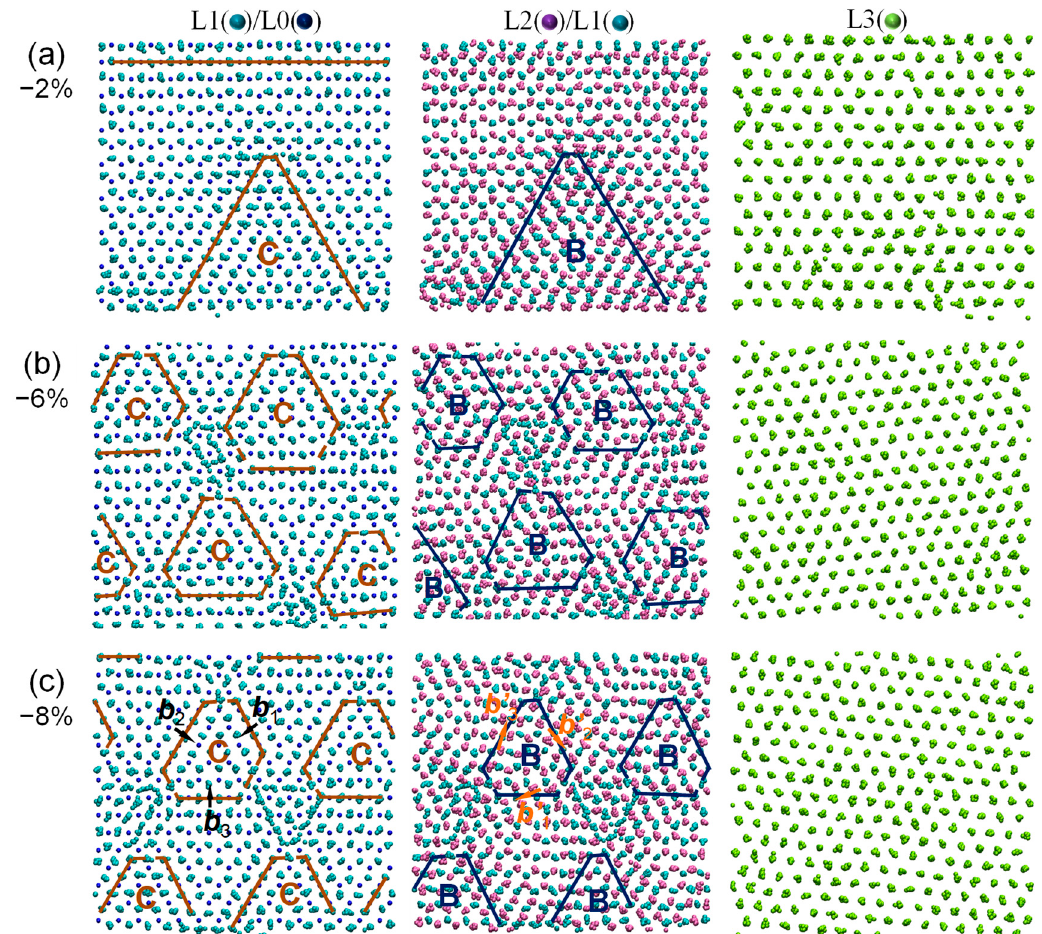
Figure 7. Time-averaged atomic positions at the interface for the systems with ( a ) f = − 2%, ( b ) − 6%, and ( c ) − 8% at t = 1 ns during the simulations at their respective T n . The b 1 , b 2 , b 3 ( b ’ 1 , b ’ 2 , b ’ 3 ) and the arrows represent the Burges vectors of the Shockley partial edge (screw) dislocations in the L1 (L2).